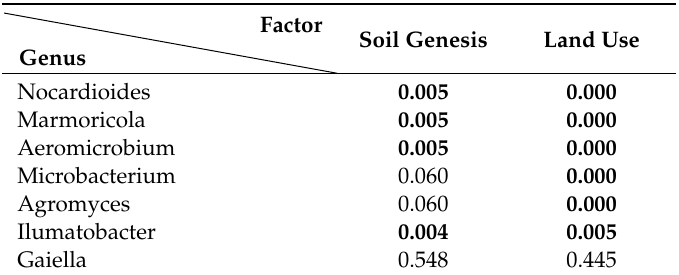
Table A3. Effect of soil genesis and mode of land use on the abundance of the most representative genera of Actinobacteria. The effects are represented as p-values of two-way ANOVA. Bolded values indicate significant effects.